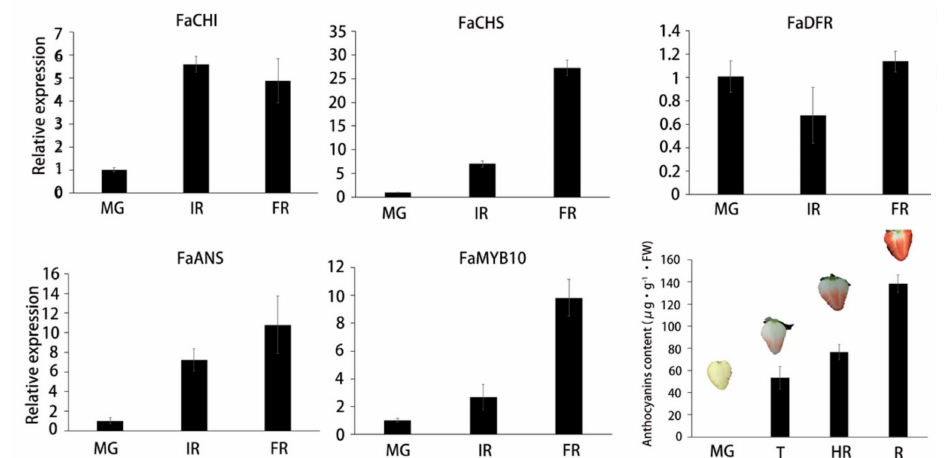
Figure 7. The qPCR-based expression levels of anthocyanin biosynthetic genes and anthocyanin content during fruit ripening. The expression of genes was normalized against the value at MG stage. Horizontal axis indicates the di ff erent developmental stages, vertical axis indicates the relative expression. MG, mature green; IR, initial red; HR, half red; FR, full red. Error bars indicate the standard deviation of three biological